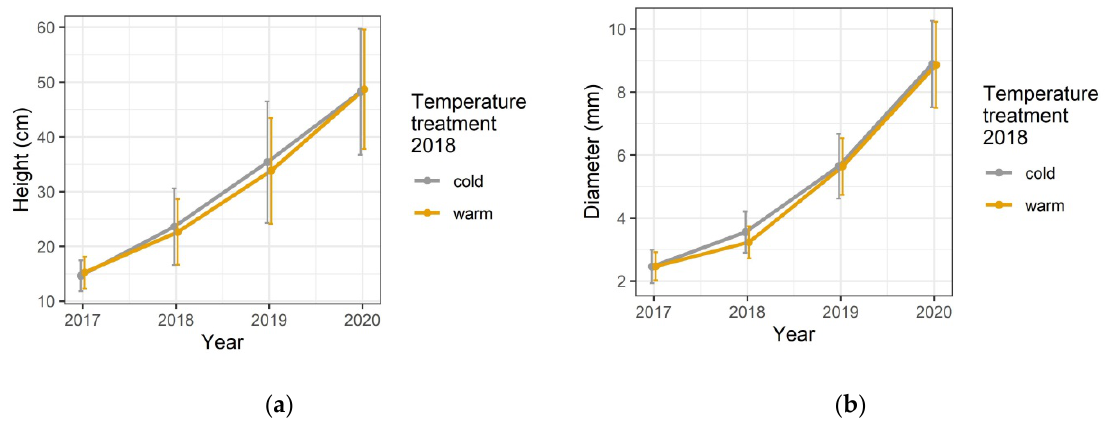
Figure 4. Mean and standard deviation for height ( a ) and diameter ( b ) of the plants from 2017 to 2020 according to the temperature treatment in the spring of